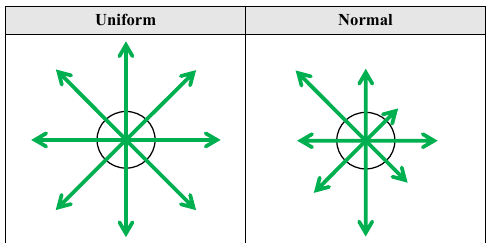
Figure 5. (Color online) Spin randomizing field vector (green arrows) directions are random at each step; two models of their magnitudes are used: either a constant magnitude (uniform) or a magnitude from a Gaussian distribution